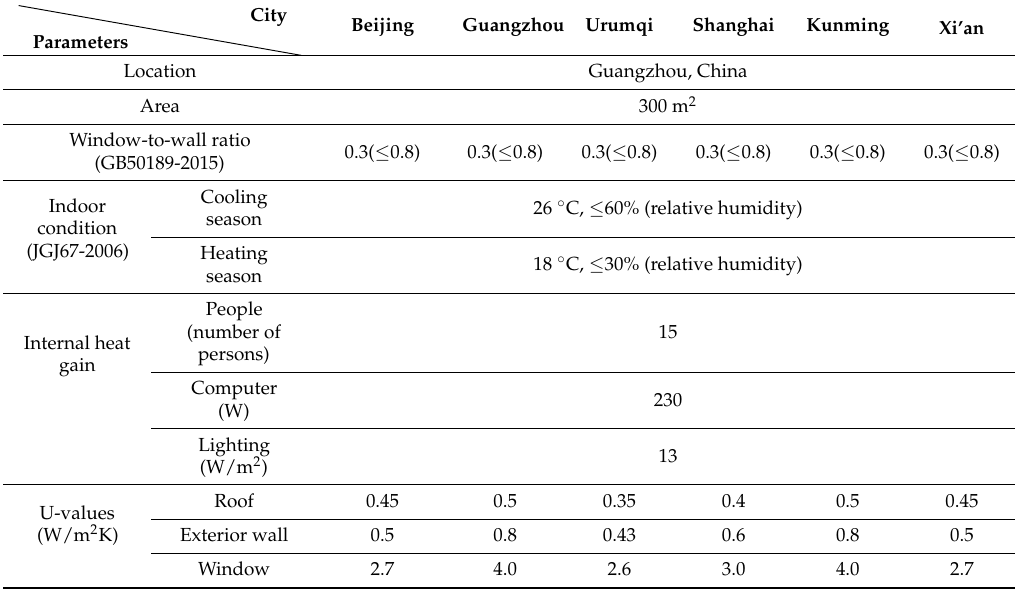
Table 1. The physical information of the model buildings studied